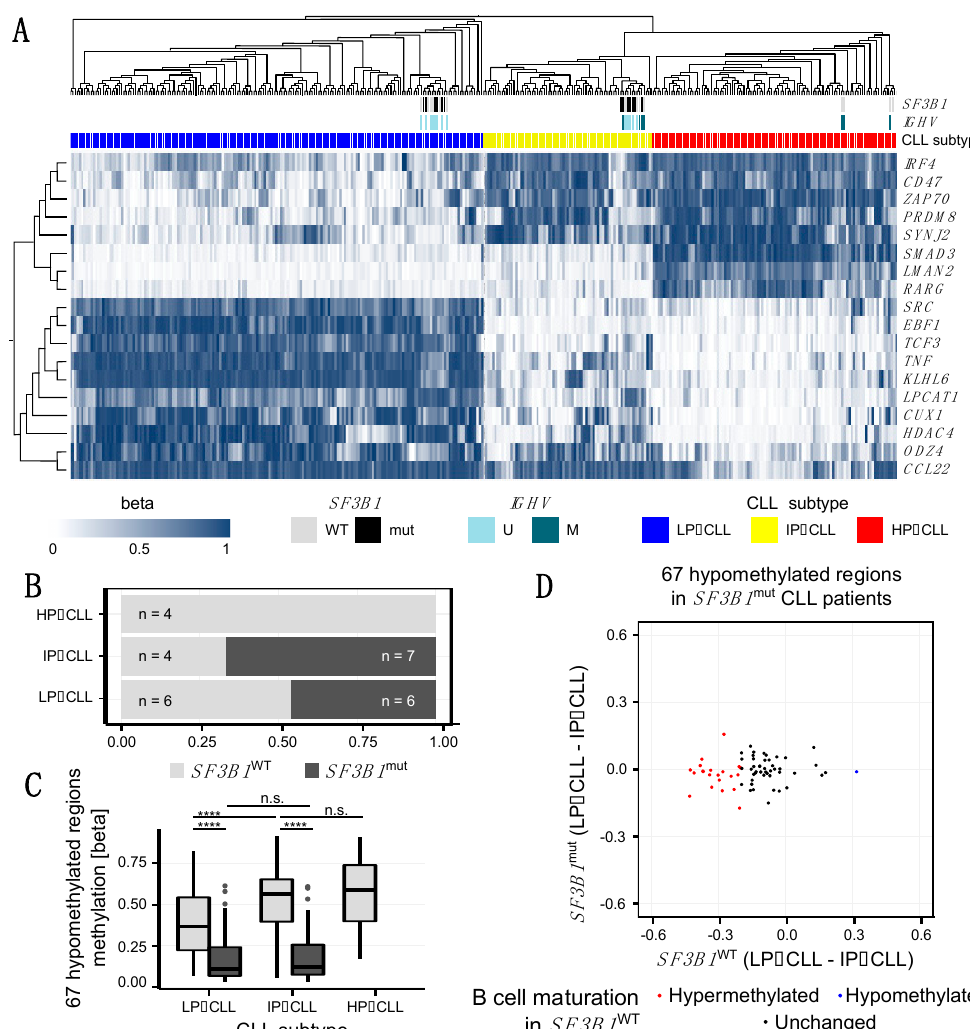
Figure 4. Changes in the DNA methylome in SF3B1 mut chronic lymphocytic leukemia (CLL) samples occur partly independent of B cell maturation. ( A ) Heatmap showing unsupervised clustering of 27 samples from this study and 329 CLL Research Consortium (CRC) samples from Oakes et al. [25] based on beta methylation values of the 18 most variable regions among the three CLL subtypes. White cells in the SF3B1 and IGHV annotations denote missing information. The inclusion of our 27 samples led to re-classification of 5 out of the 329 CRC samples (< 2%) from the LP-CLL to the IP-CLL subtype. ( B ) Proportion of SF3B1 WT and SF3B1 mut samples among the three CLL subtypes. ( C ) Methylation values of the 67 hypomethylated regions SF3B1 mut samples according to the SF3B1 mutational status and CLL subtype. Wilcoxon test significance is denoted by stars with p -value < 0.0001 = “****”; ≥ 0.05 = “ns”. ( D ) Comparison of the methylation programming between CLL patients with and without SF3B1 mutation within 67 differentially methylated regions (DMRs) identified between SF3B1 mut CLL and SF3B1 WT CLL samples. Due to the lack of high-programmed CLL samples with SF3B1 mut in our dataset ( B ), the methylation programming is shown as the difference between the average methylation of low-programmed (LP-) and the average methylation of intermediate-programmed (IP-) CLL samples in each of the SF3B1 mutational groups. ( B ) cell development-related DMRs hypo- or hyper-methylated in LP-CLL vs. IP-CLL in wild type samples (difference ≥ 20% in SF3B1 WT ) are shown in blue and red, respectively.